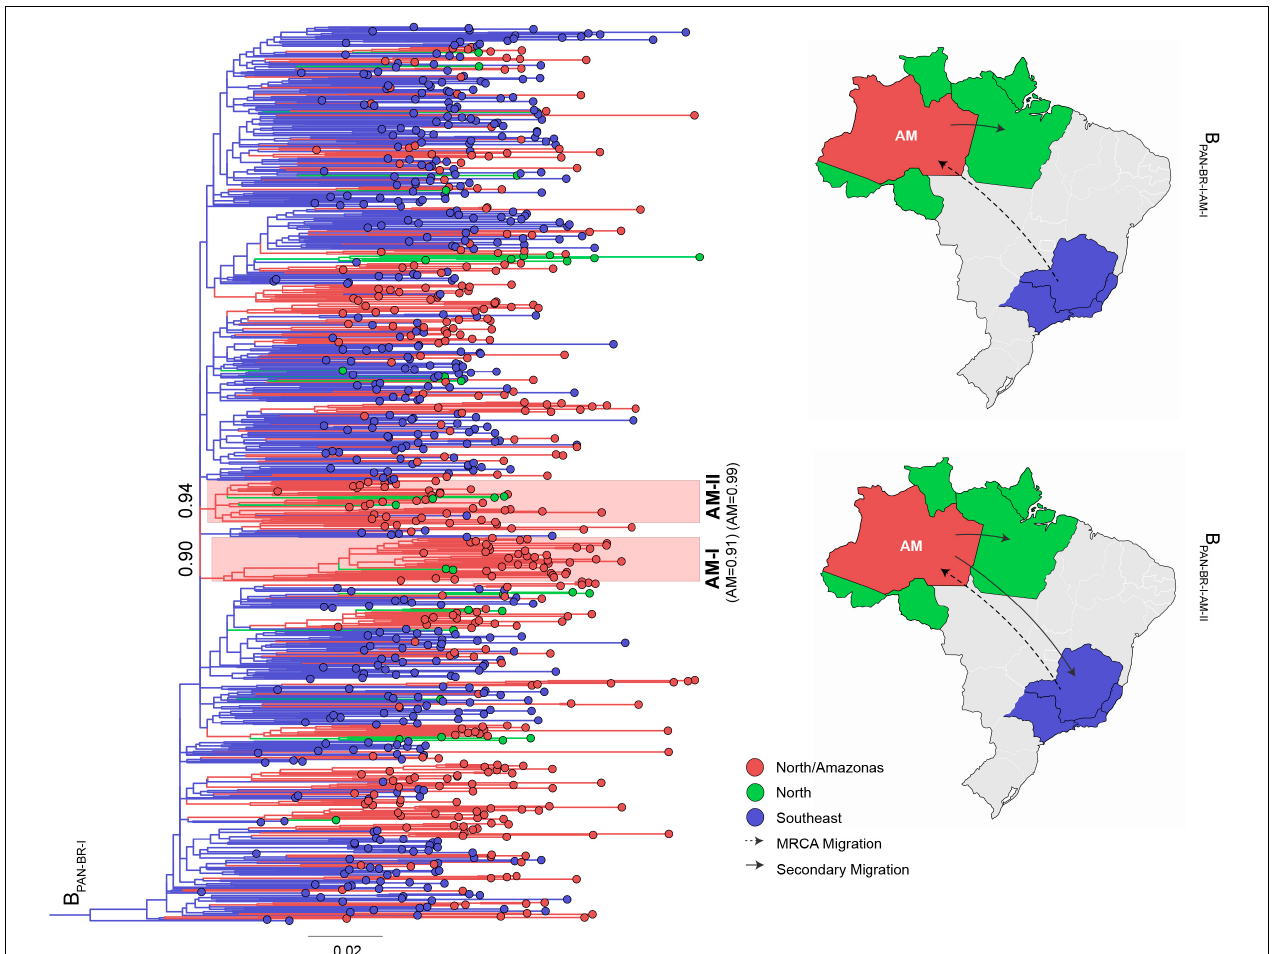
FIGURE 2 | ML phylogeographic analysis of major B PAN − BR − I cluster disseminated in Brazil. A total of 844 B PAN − BR − I Brazilian sequences sampled in Amazonas ( n = 360) and other states from the Northern and Southeastern regions ( n = 484) were analyzed together. We selected sequences from Northern and Southeastern states because were the regions more strongly connected with the Amazonas state. Major Amazonian clades B PAN − BR − I − AM − I and B PAN − BR − I − AM − II are indicated by colored shaded boxes along with cluster aLRT support (number at basal branch) and the inferred marginal probability that cluster ancestor was located in Amazonas state (in parentheses). The location of taxonomic units at internal nodes across the ML tree was reconstructed and represented according to the color scheme shown in the map. Sequences were grouped in three discrete locations: Amazonas state (AM), Northern region (N), and Southeastern region (SE). The tree was rooted using HIV-1 subtype D reference sequences (not shown). The branch lengths are drawn to scale with the bar at the bottom indicating nucleotide substitutions per site. Major migrations of viral clades B PAN − BR − I − AM − I and B PAN − BR − I − AM − II are represented in the